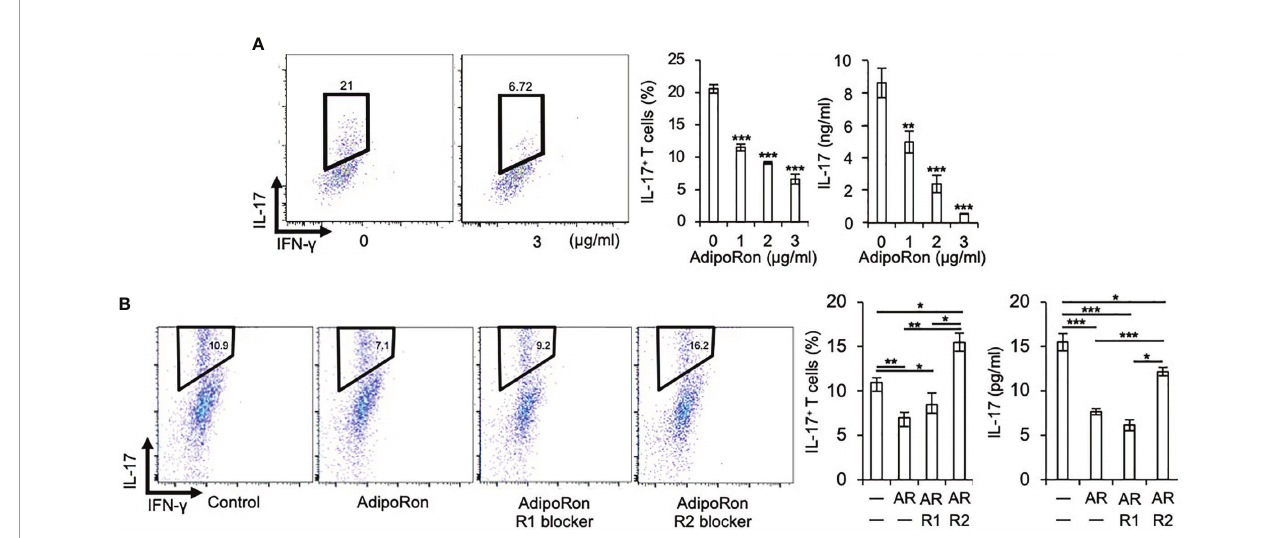
FIGURE 2 | AdipoRon suppresses Th17 cell differentiation via AdipoR2. (A) C1qtnf3 – / – naïve CD4 + T cells were cultured under Th17-polarizing conditions in the absence or presence of AdipoRon (0, 1, 2 and 3 m g/ml) for 5 days (n = 4 wells each). Intracellular IL-17 expression was estimated by fl ow cytometry after PMA/ ionomycin stimulation. The number in each panel indicates percentage of IL-17 + CD4 + T cells (2 left panels). The population of IL-17 + CD4 + T cells (center). IL-17 concentrations in culture supernatant determined by ELISA (right). Average and SEM are shown. ** p < 0.01 and *** p < 0.001. Student ’ s t -test. (B) C1qtnf3 – / – naïve CD4 + T cells were cultured under Th17-polarizing conditions in the absence or presence of AdipoRon (1 m g/ml, Ron) for 4 days (n = 3 wells each), and the effect of AdipoR1 (10 m g/ml, R1) or AdipoR2 blocker (10 m g/ml, R2) on the Th17 cell differentiation was examined. Intracellular IL-17 expression was estimated by fl ow cytometry after PMA/ionomycin stimulation. The Number in each panel indicates percentage of IL-17 + CD4 + T cells (4 left panels). The population of IL-17 + CD4 + T cells (center). IL-17 concentrations in culture supernatant determined by ELISA (right). Average and SEM are shown. * p < 0.05, ** p < 0.01 and *** p < 0.001. Student ’ s t -test. All data were reproduced in another independent experiment with similar